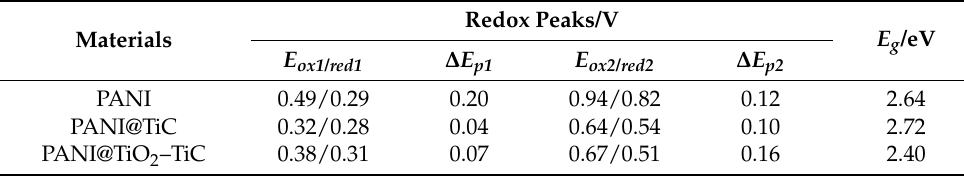
Table 3. Optical bandgap ( E g ) and Redox peak of the synthesized